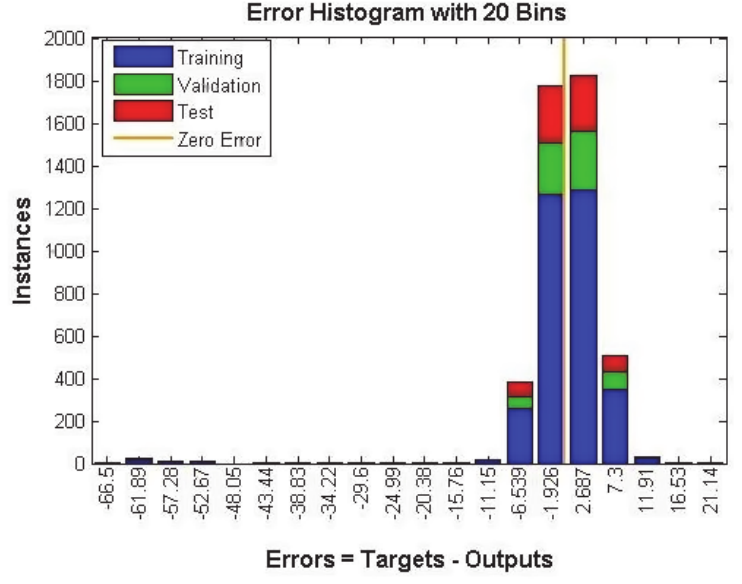
Fig. 11. Error histogram of ST model